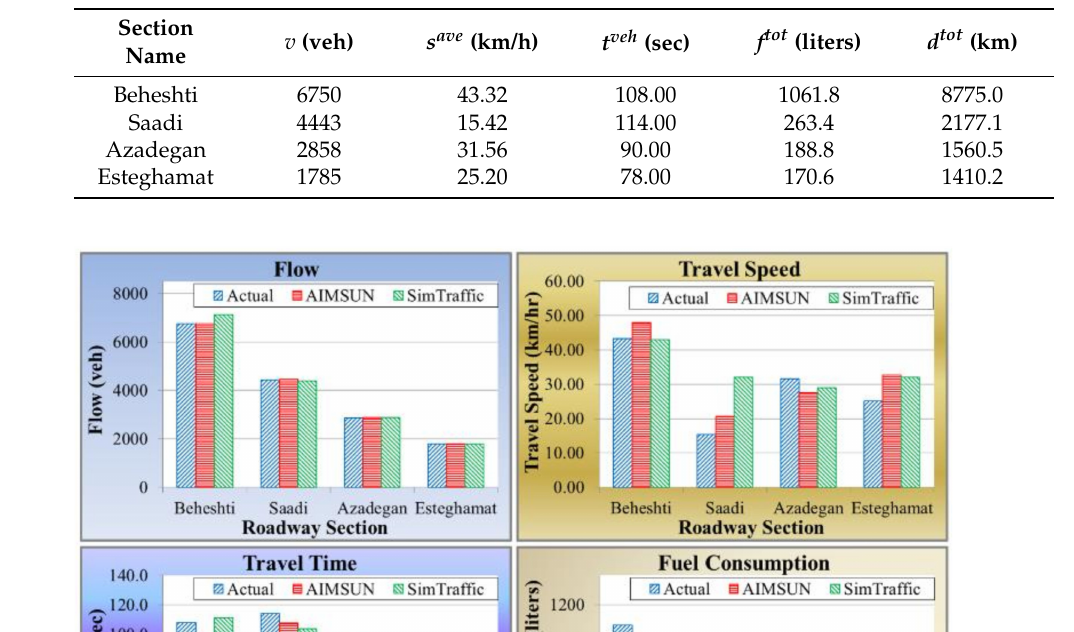
Table 10. Actual values of the performance indicators for the selected roadway sections.